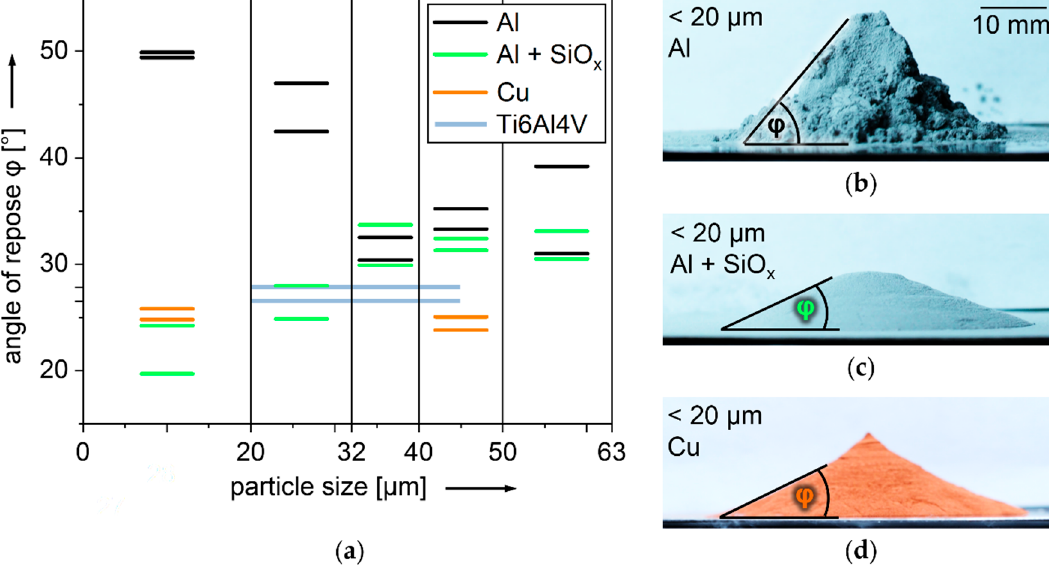
Figure 7. Lowering cohesion by dry coating SiO x nanoparticles, visualized with angle of repose in the style of ISO 4324 [64]; ( a ) comparison of powder fractions; ( b ) pile of Al < 20 µm, φ = 50°; ( c ) pile of Al < 20 µm dry coated with 0.3 wt% SiO x nanoparticles, φ = 24°; ( d ) pile of Cu < 20 µm, φ = 26°.